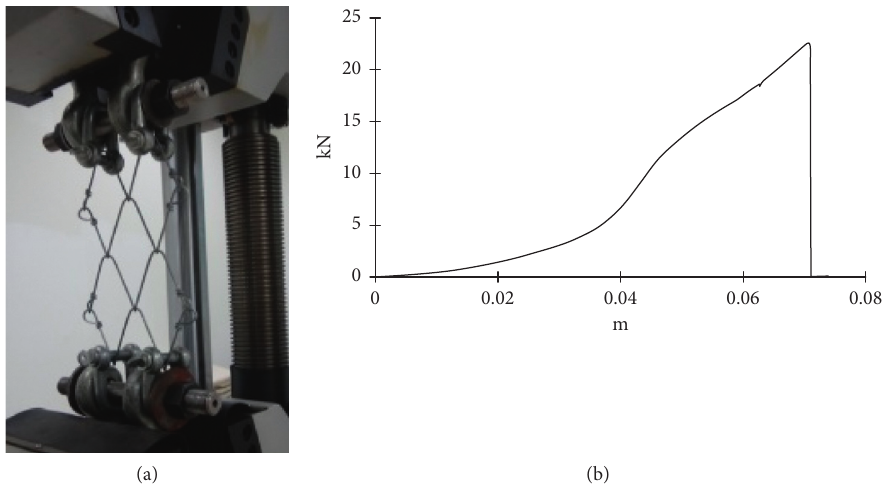
Figure 6: Tensile test of the four-mesh metal flexible net. (a) Tensile test. (b) Load-displacement curve. Table 3: The mechanical parameters of various materials in numerical calculation. Material type